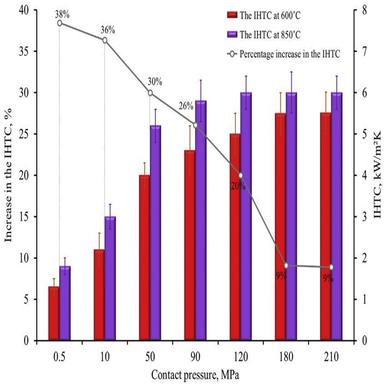
The percentage increase in the IHTC for the Ti-6Al-4V caused by the increasing temperature from 600 °C to 850 °C.